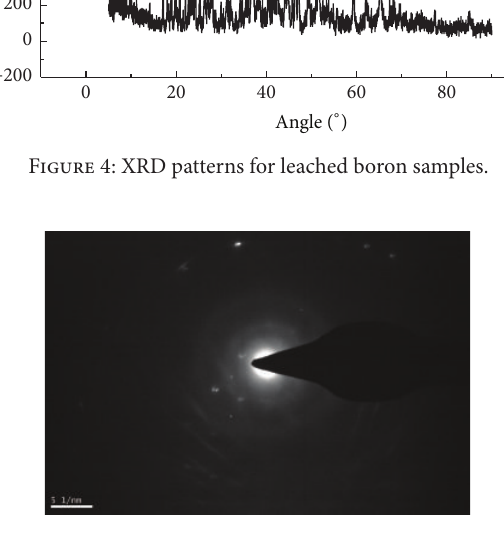
Figure 5: SEAD chart of leached B